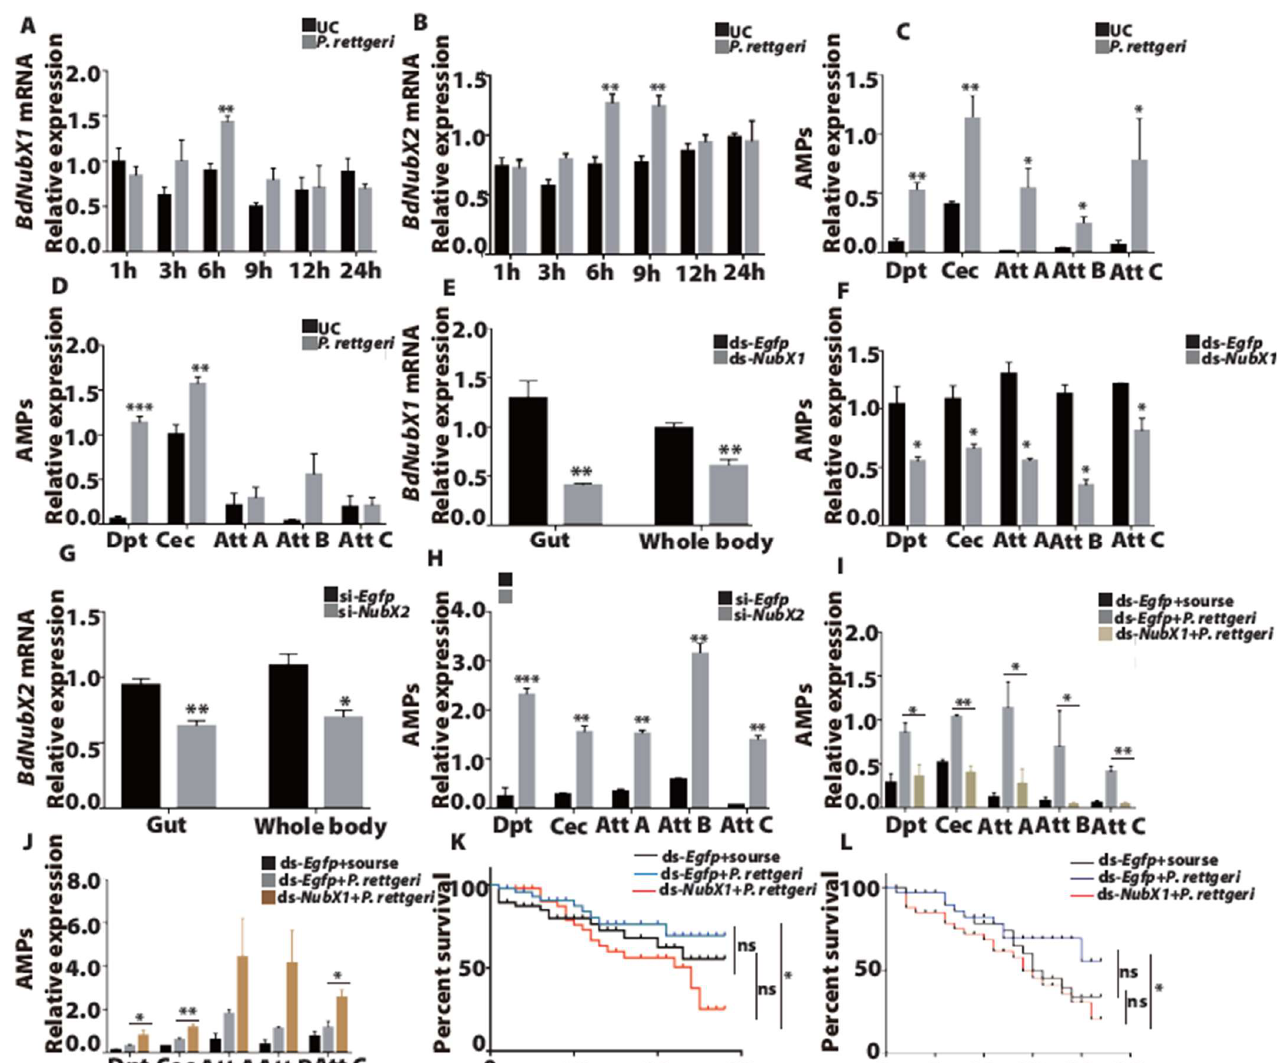
Figure 4. The immune response of BdNub after P. rettgeri oral infection. ( A , B ) The relative expression level of BdNubX1 and BdNubX2 after P. rettgeri oral infection. ( C , D ) The relative expression of the AMPs genes at 6h and 9h after oral infection, respectively. ( E ) The RNAi effect of BdNubX1 dsRNA injection. ( F ) The expression levels of AMPs genes in BdNubX1 RNAi flies. ( G ) The RNAi effect of BdNubX1 siRNA injection. ( H ) The expression levels of AMPs genes in BdNubX2 RNAi flies. ( I , J ) The AMPs genes expressions at 6 h after P. rettgeri oral infection in BdNubX1 RNAi flies (I) and BdNubX2 RNAi flies ( J ). ds Egfp treated group was used as the control for RNAi. ( K , L ) The survival of BdNubX1 RNAi and BdNubX2 RNAi flies after rate after P. rettgeri oral infection. ( A – L ) 30 flies samples per biological replicate, three biological replicates. * p < 0.05, ** p < 0.01, *** p < 0.001, Student’s t -test.